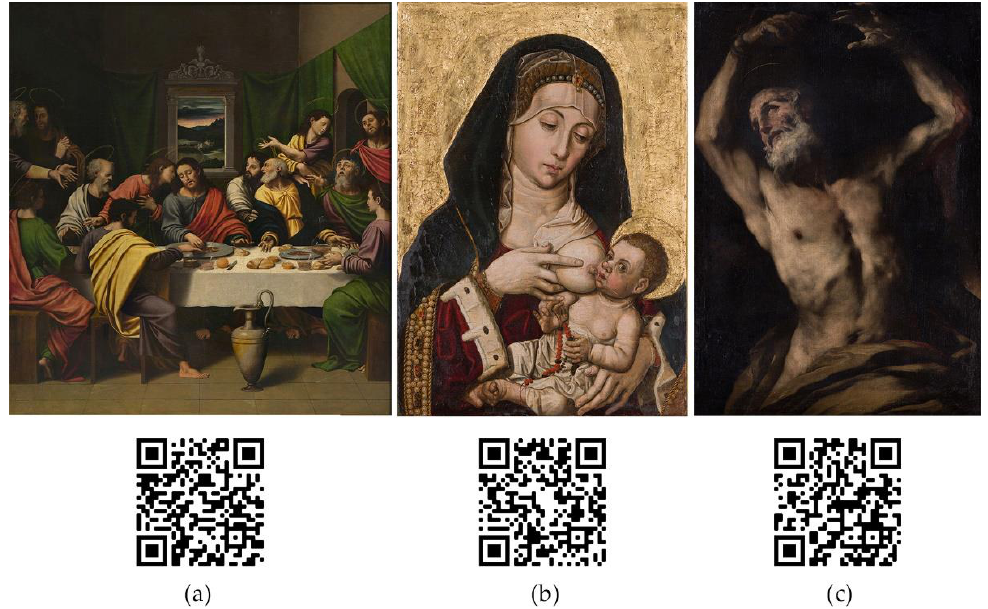
Figure 20. For an interactive gigapixel visualization of the documented artworks use the QR codes or follow the links below. ( a ) https://gpix.webs.upv.es/gpix/305.html (accessed on 19 August 2021);